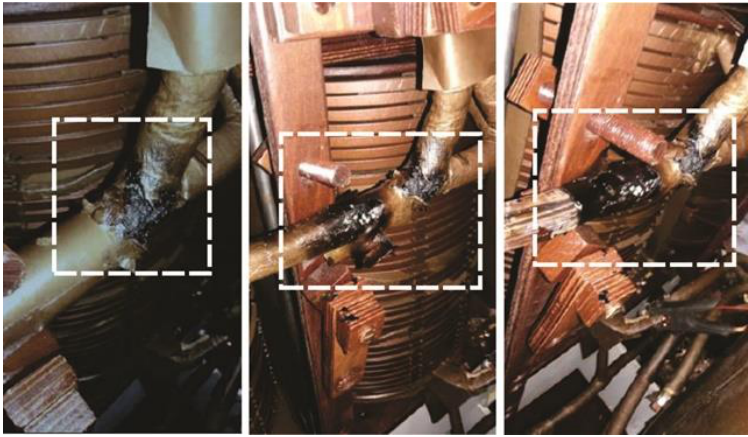
Figure 27. Degradation in the physical connection of the low voltage (LV) windings.